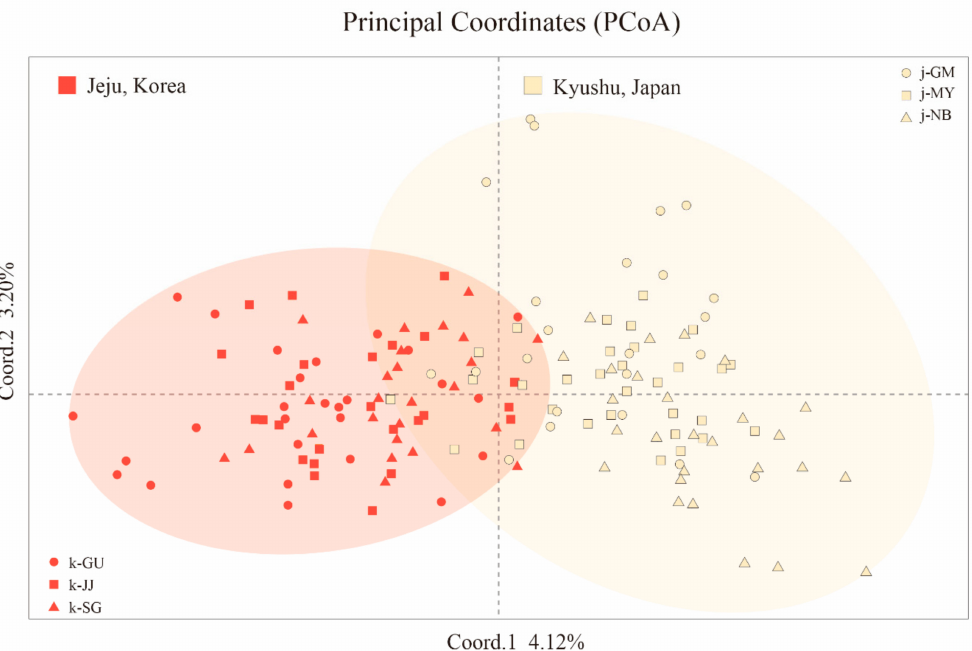
Figure 5. Principal coordinates analysis based on Nei’s genetic distance calculated from the allele frequencies of the 158 individuals for Quercus gilva . The orange symbols indicate individuals of Jeju region, and the yellow ones indicate Kyushu region. Six subgroups indicate each populations of Q. gilva